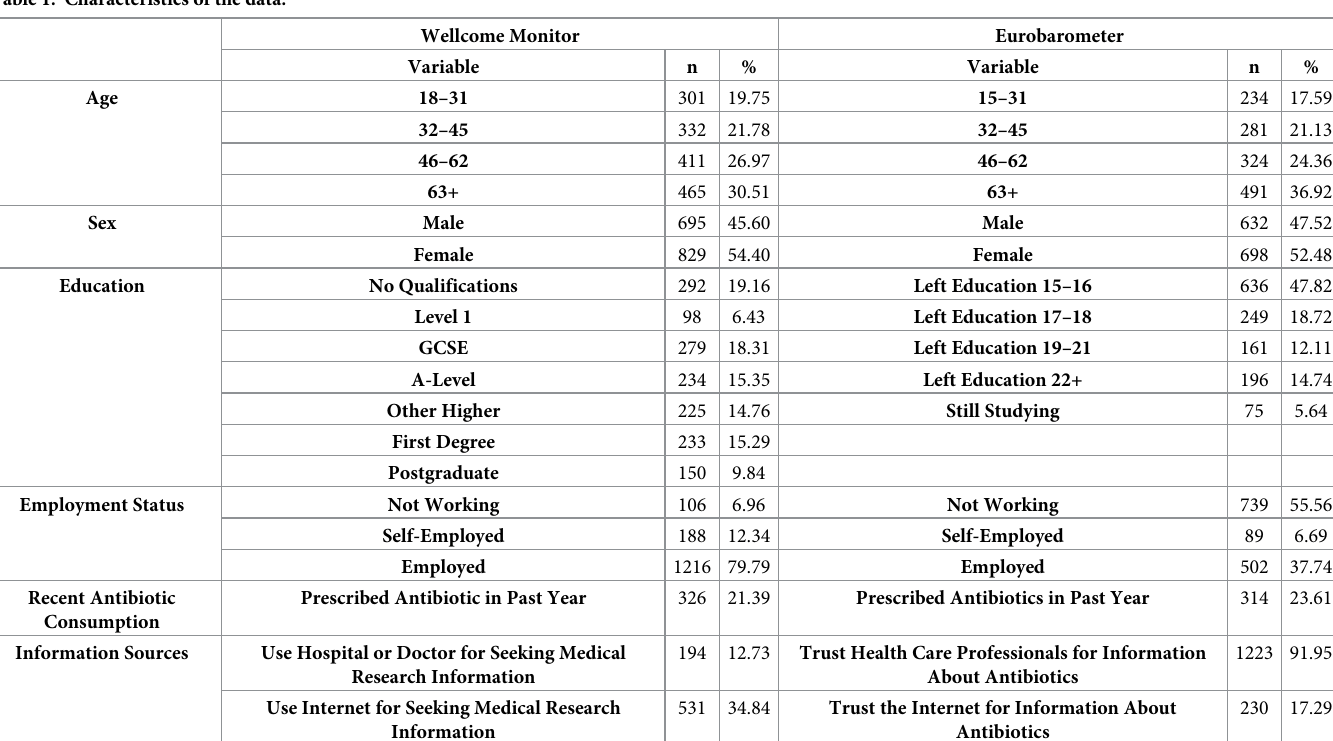
Table 1. Characteristics of the